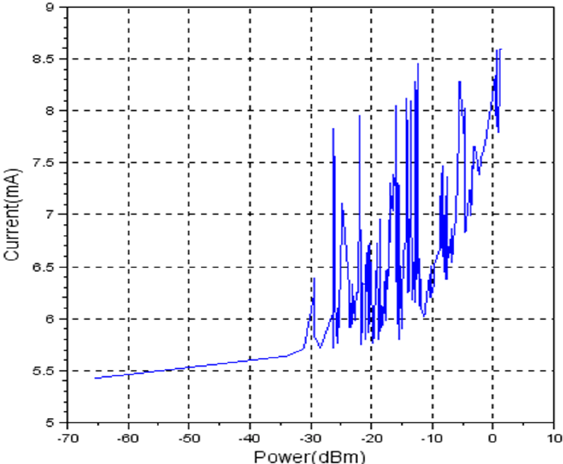
Figure 10. Current vs. transmission power for fully charged batteries (VBAT = 3.16 Volts).